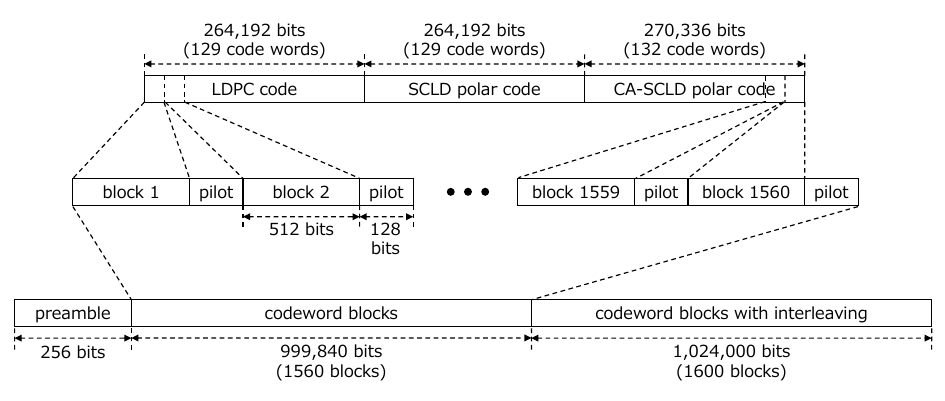
Figure 4. Data frame format for transmission experiment.